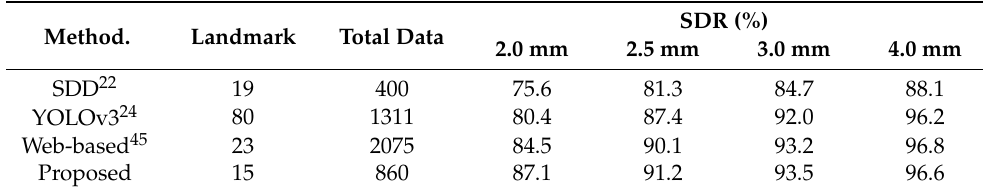
Table 5. Comparison of automatic landmark identification system prediction results.